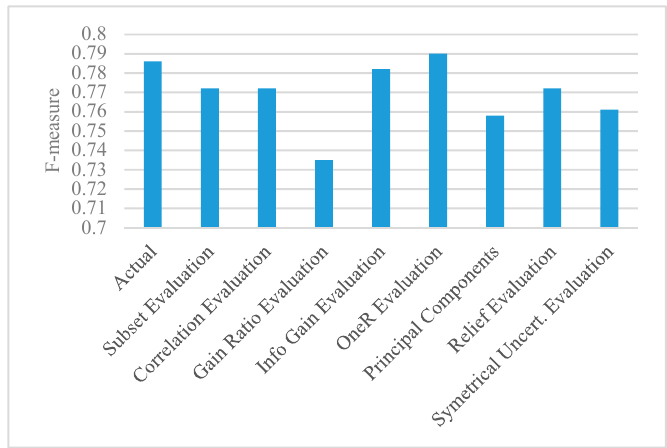
Figure 4. AdaBoost performance based on the F-measure for the Actual 1024 attributes and the F-measure based on the attributes selected by the corresponding algorithm.